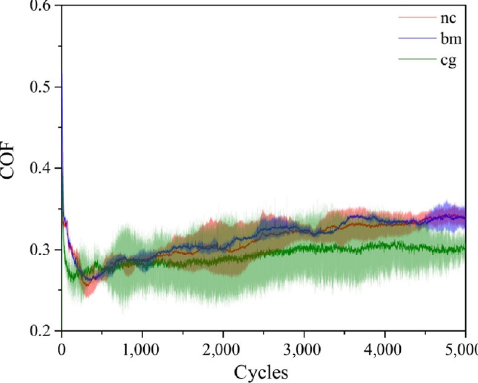
Fig. 3 High-cycle evolution of the COF (up to 5,000 sliding cycles) of all tested microstructures at a normal load of 5 N. The shaded areas represent the standard deviation of the